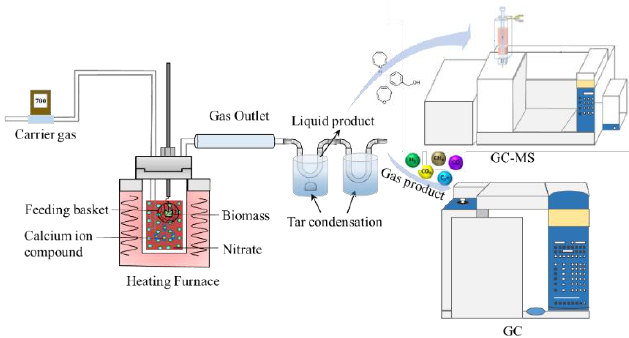
Figure 12. Schematic diagram of the molten salts pyrolysis